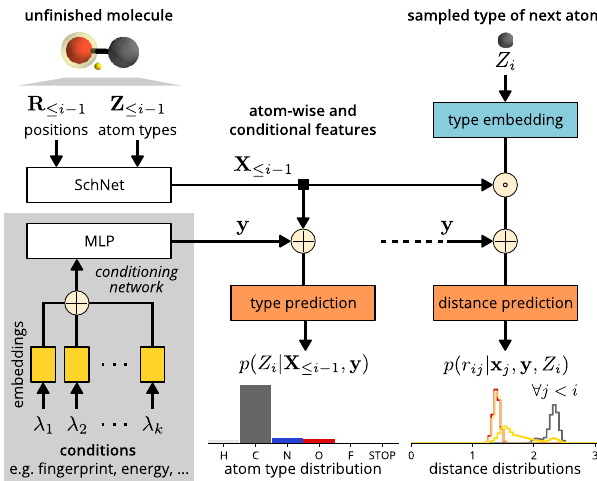
Fig. 2 Schematic depiction of the cG-SchNet architecture with inputs and outputs. “ ⊕ " represents concatenation and “ ⊙ " represents the Hadamard product. Left: Atom-wise feature vectors representing an un fi nished molecule are extracted with SchNet 67 and conditions are individually embedded and then concatenated to extract the conditional features vector. The exact embedding depends on the type of the condition (e.g., scalar or vector-valued). Middle: The distribution for the type of the next atom is predicted from the extracted feature vectors. Right: Based on the extracted feature vectors and the sampled type of the next atom, distributions for the pairwise distances between the next atom and every atom/token in the un fi nished molecule are predicted. See Methods for details on the building